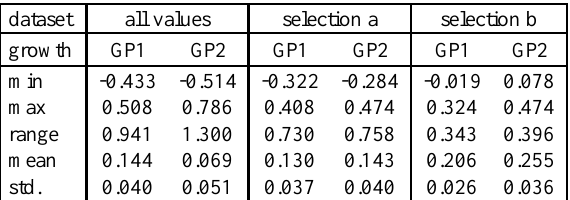
Table 1. Descriptive statistics of plant heights [m] derived from CSMs for all data and selected datasets a and b according to